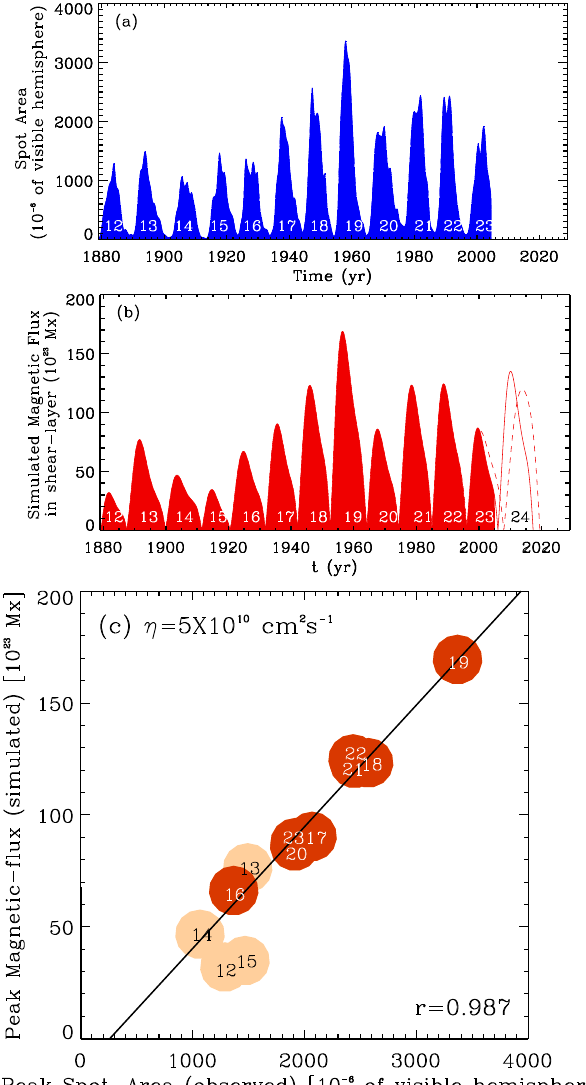
Fig. 5. (a) Observed sunspot area data for cycles 12–23; (b) integral from 0 − 45 ◦ latitude of simulated toroidal magnetic flux in bottom shear layer for cycles 12–24, plus two forecasts for cycle 24; (c) scatterplot of sunspot area peaks vs peak of toroidal magnetic flux